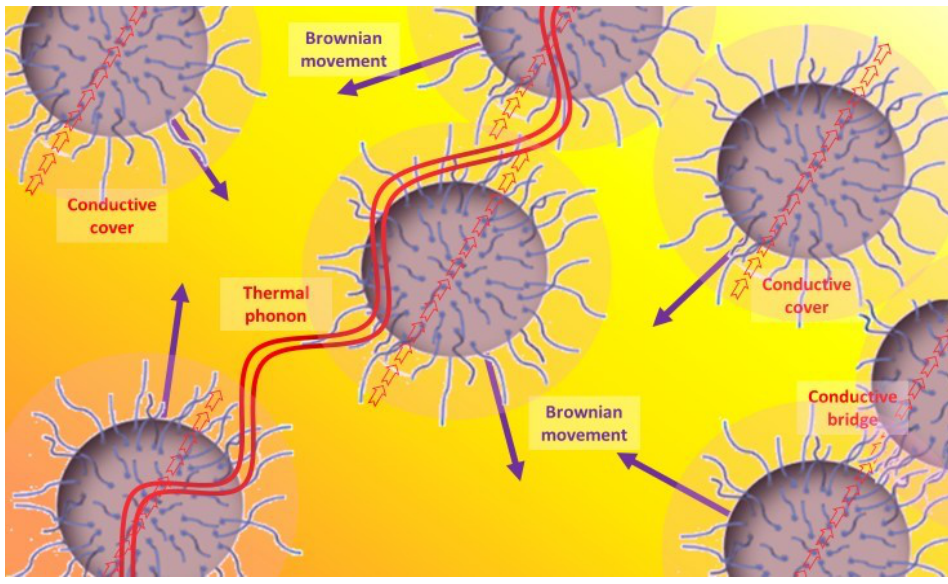
Figure 7. Heat transference mechanisms in nanofluids.